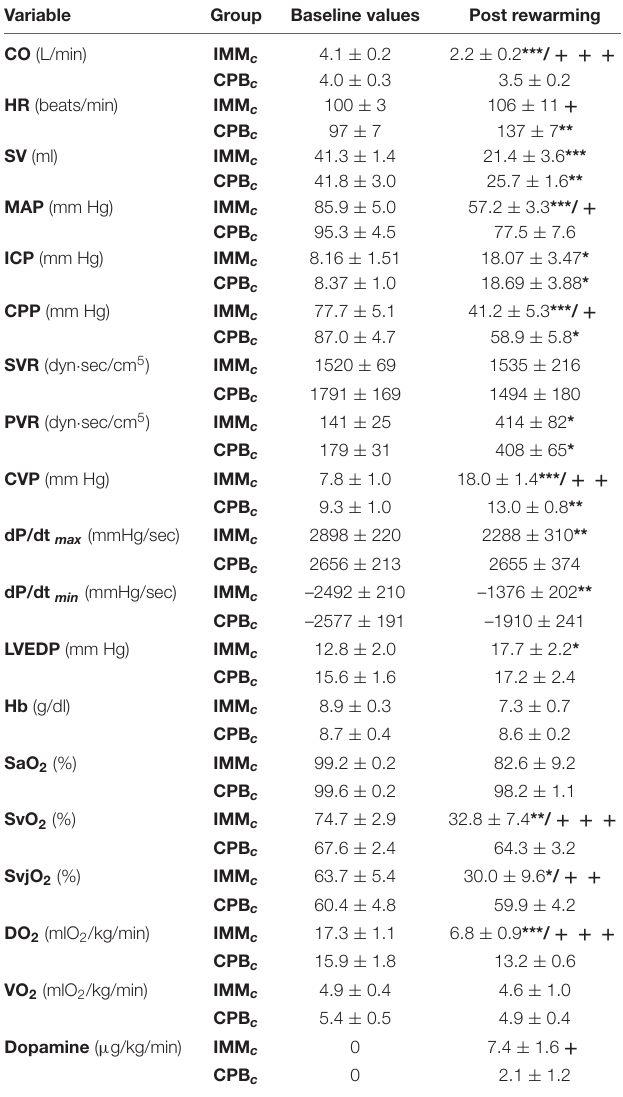
TABLE 1 | Flow- and pressure-derived variables, oxygen variables and dopamine administration before and after cooling. Variable Group Baseline